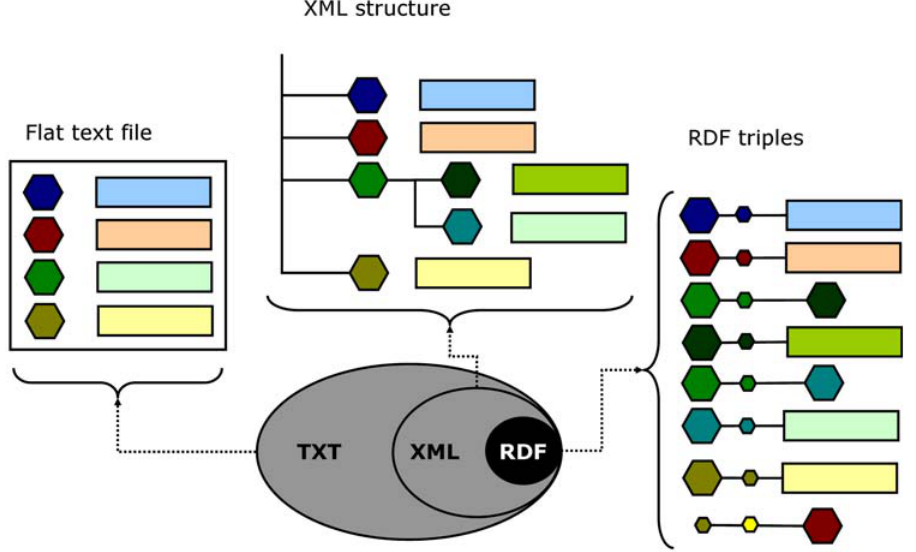
Figure 2. Evolution of formats for individual datasets. Hexagons, rectangles and small circles indicate data elements, respectively, attributes, their values, and relations. First, flat file formats such as fasta or the GeneBank data model were proposed to collect attribute-value pairs about an individual data entry. The use of tagging by extended markup languages (XML) allowed for the embedding of additional detail and further definition of the nature of the hierarchical structure between data elements. More recently, the resource description framework (RDF) further generalized the XML tree structure into that of a network where the relationship between resources (nodes) is a resource itself. Furthermore, the referencing of each resource by a unique identifier (URI) implies that the data elements can be distributed between distinct documents or even locations.